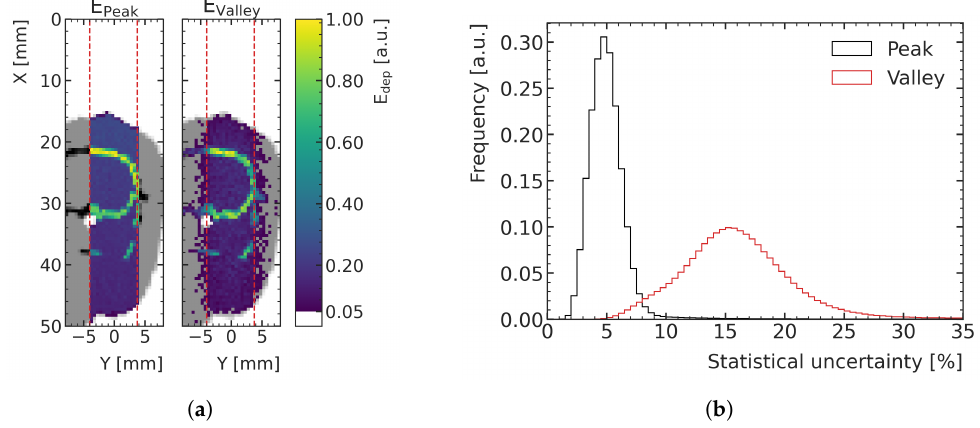
Figure 3. ( a ) Two-dimensional slice of the MC-simulated energy deposition in the peak (left) and valley (right), respectively, at the center of the prediction volume for an exemplary high-noise training sample (rat number 1), normalized to their respective maximum. The prediction volume is indicated with red dashed lines. Air is shown white, tissue (water) in gray and bone in black. ( b ) Histograms of the voxelwise statistical uncertainties (quantified with the standard error) of the peak and valley energy deposition MC simulations in the high-noise